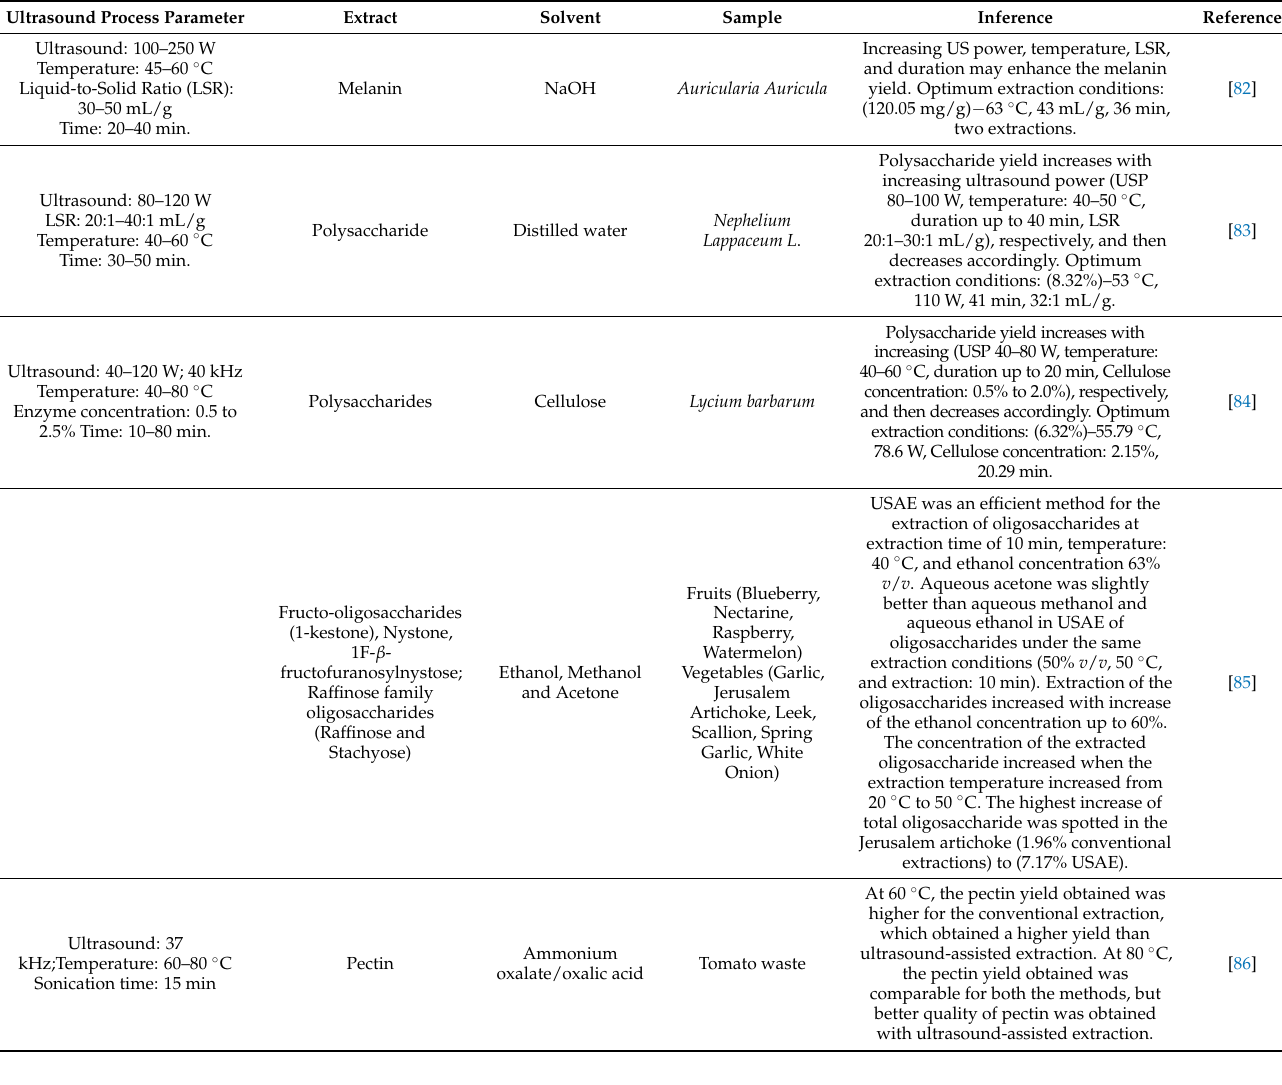
Table 4. Effect of ultrasound on